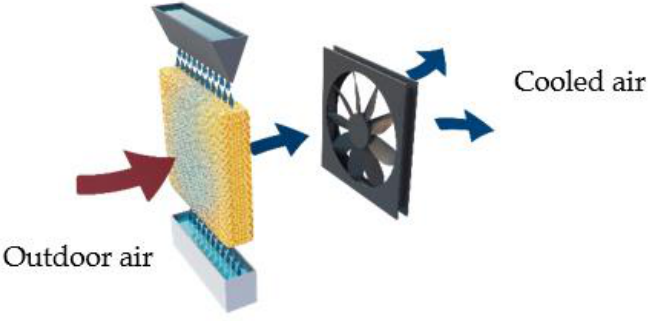
Figure 3. Principle scheme of adiabatic cooling.